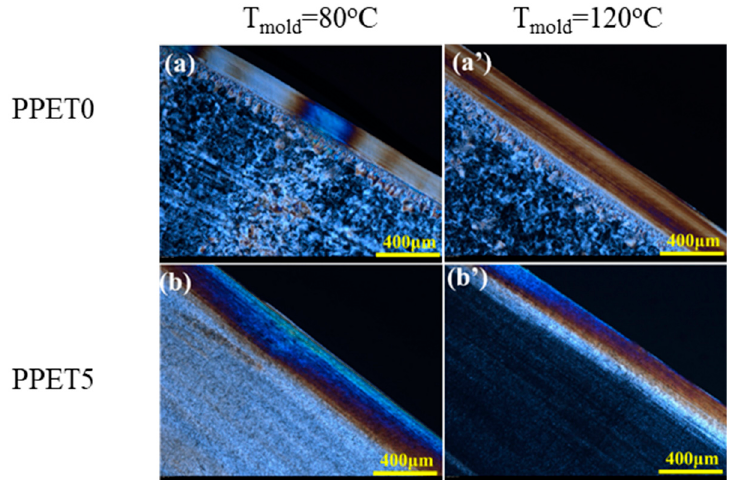
Figure 7. PLM images of crystalline structure in C-parts.